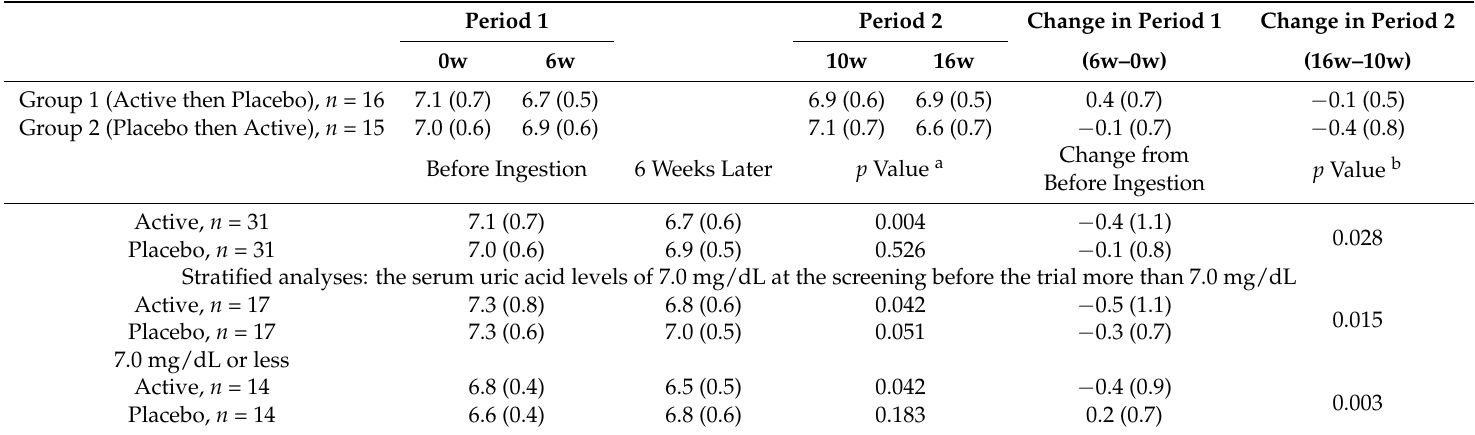
Table 3. Summary of serum uric acids concentrations (mg/dL) in the crossover